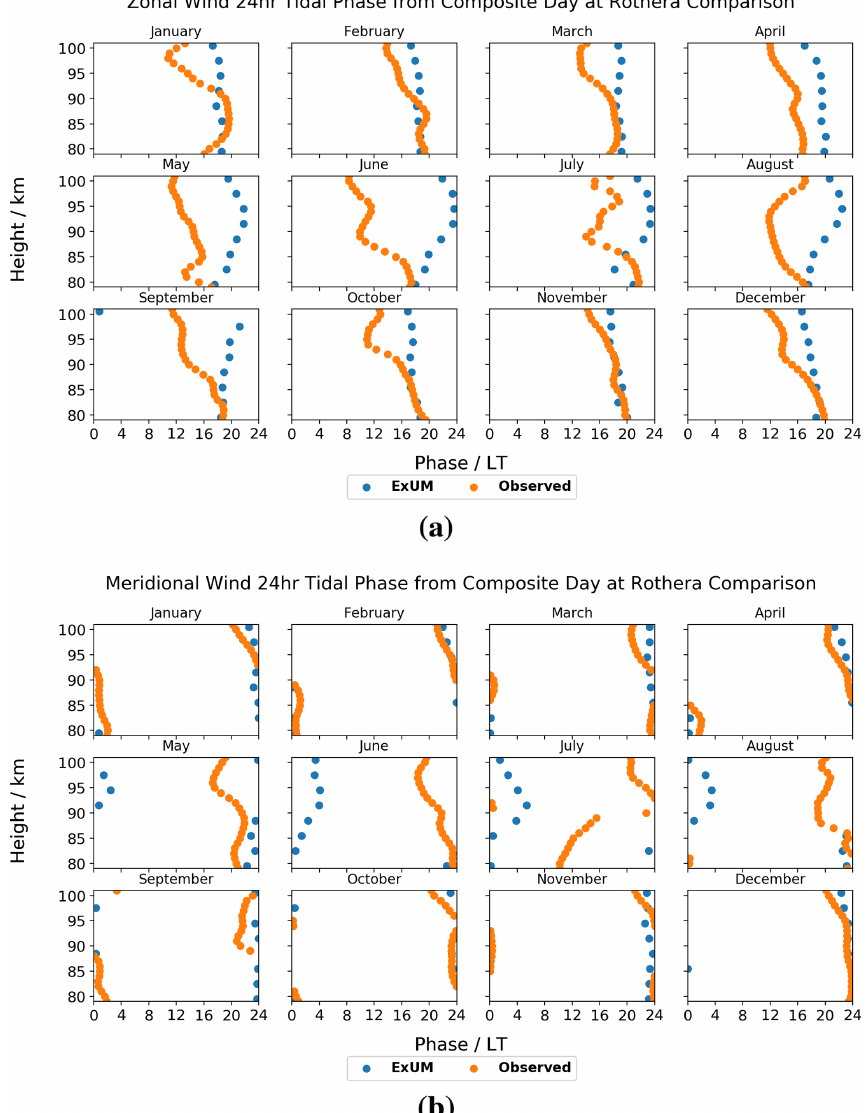
Figure 11. Phases for each month as a function of height for the (a) zonal ( u ) and (b) meridional ( v ) components of the diurnal tide at Rothera. Both the phases from the model (blue) and meteor radar (orange) are